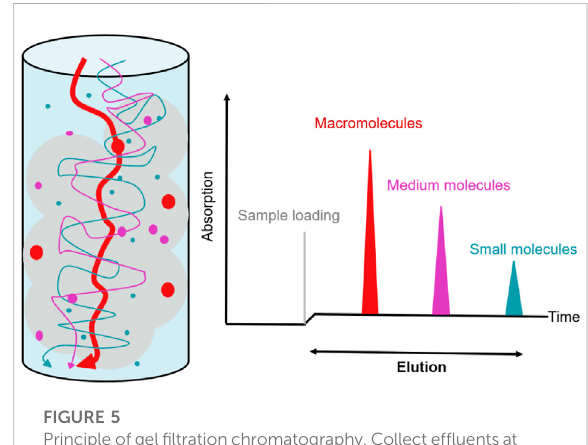
FIGURE 5 Principle ofgel fi ltrationchromatography.Collectef fl uentsat different times according to different target protein